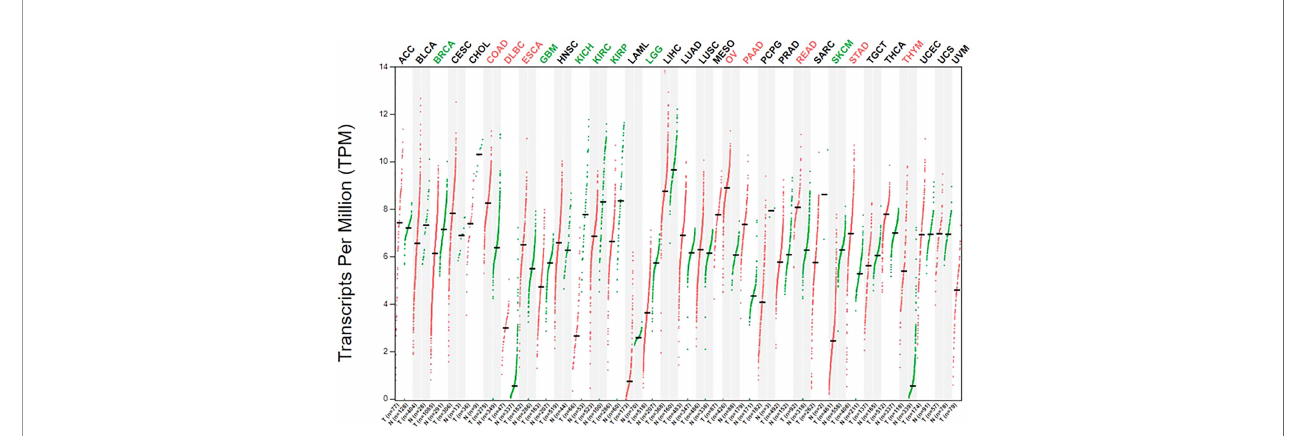
FIGURE 2 | The expression of ASS1 in human normal tissue and cancer cells.The gene expression pro fi le across all tumor samples and paired normal tissues. The fi gure was excerpted from GEPIA2